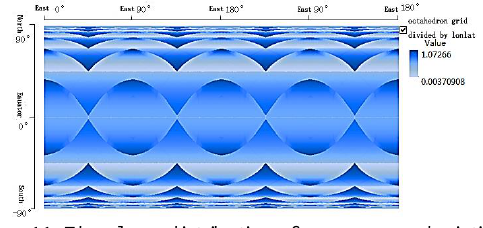
Figure 11. The planar distribution of mean square deviation of major-minor of octahedron grid divided by mixed method